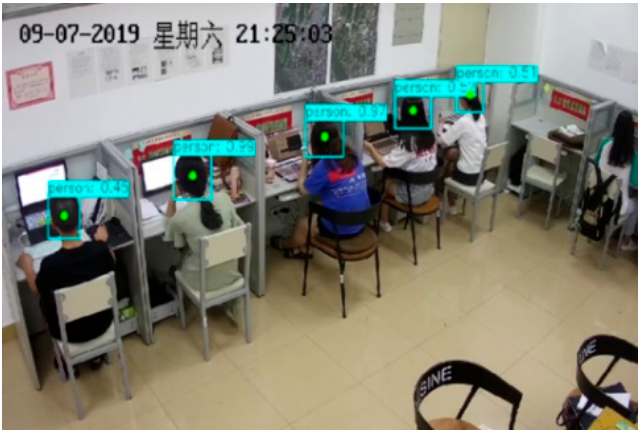
Figure 9. The detection effect of office employees’ heads.